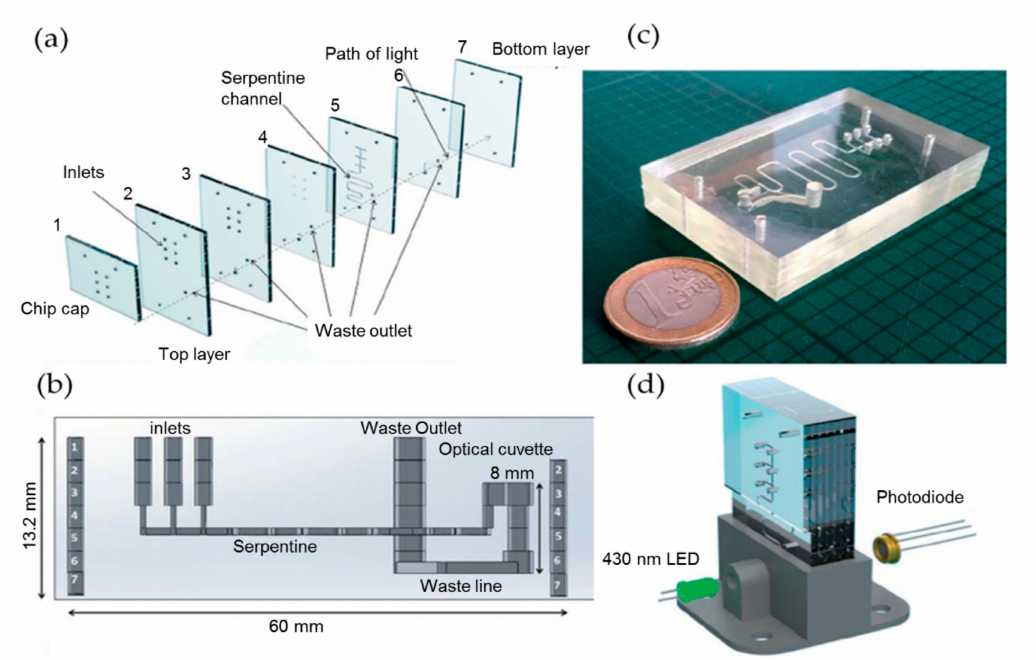
Figure 2. ( a ) Assembly diagram of microchip layers. ( b ) The chip layers that are fully assembled and the micro-cuvette. ( c ) The PDMS microfluidic chip. ( d ) Setup of the microfluidic chip and the optical detection module with LED and photodiode. Images reproduced from